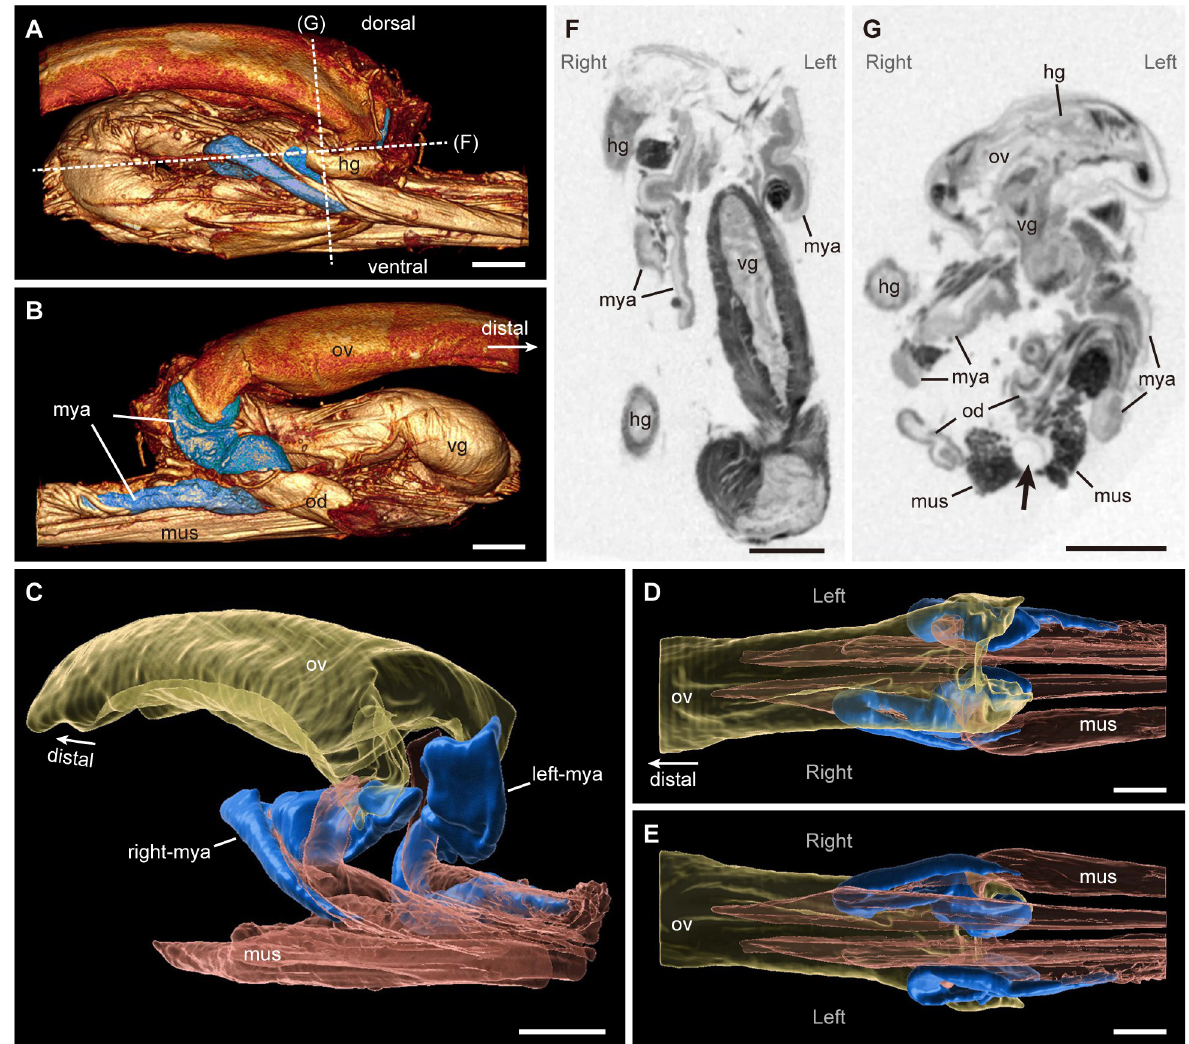
Fig 2. Micro-computed tomography (CT) of a dissected female genitalia of Leptura ochraceofasciata . (A–E) 3D reconstruction of female genitalia including mycetangia (blue) based on micro-CT, right lateral (A), left lateral (B), right diagonal (C), dorsal (D), and ventral (E) views. Mycetangia, the ovipositor (yellow), and musculature (red) along the spiculum ventrale of sternum VIII are shown in (C–E). (F, G) Single micro-CT sections of female genitalia from dashed lines in (A), ventral (F) and anterior (G) views. Note that some organs including the spiculum ventrale of sternum VIII and parts of the oviducts and hindgut were removed prior to scanning. A part of hindgut image was also removed for improving the visuality of mycetangia in (A). A black arrow indicates the original position of the spiculum ventrale of sternum VIII in (G). Abbreviations: hg, hindgut; mus, musculature along spiculum ventrale of sternum VIII; mya, mycetangium; od, lateral oviduct; ov, ovipositor; vg, vagina. Scale bars = 300 μ